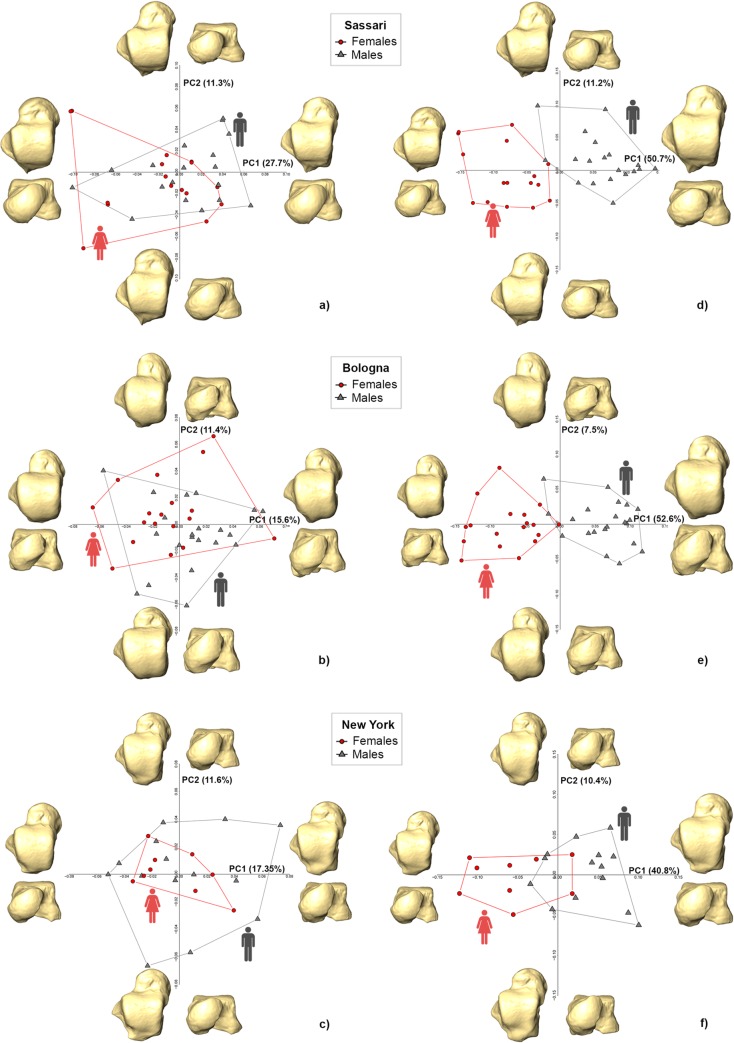
Shape (left) and form (right) space PCA plots for Sassari (a and d), Bologna (b and e) and New York (c and f). The deformed mean tali in the four directions of the PCs are drawn at the extremity of each axis.